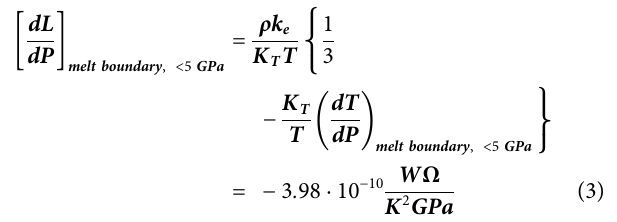
Frontiers in Earth Science |